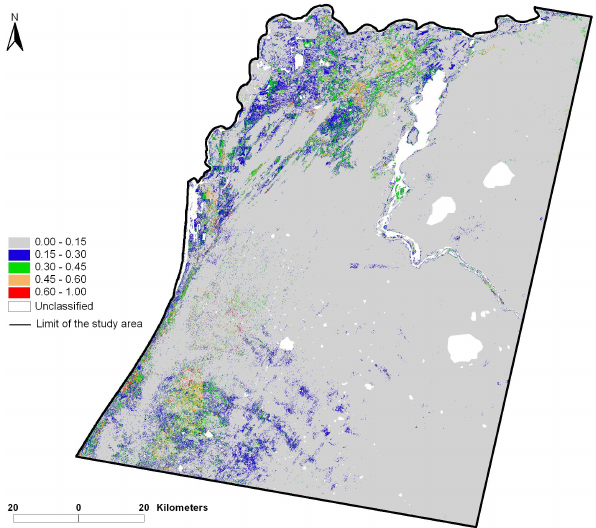
Fig. 5. The soil organic carbon (SOC) coefficient derived from the 30 soft decision tree classification model runs. The coefficient of variation (standard deviation divided by mean) is dimensionless. The 2000 Landsat data were classified 30 times into one of more the 9 LCLU classes and the SOC modeled for the corresponding spatially explicit model inputs for those classes. White shows areas where no SOC was modeled (water bodies, clouds, cloud shadows, settlement areas, or no Landsat data).